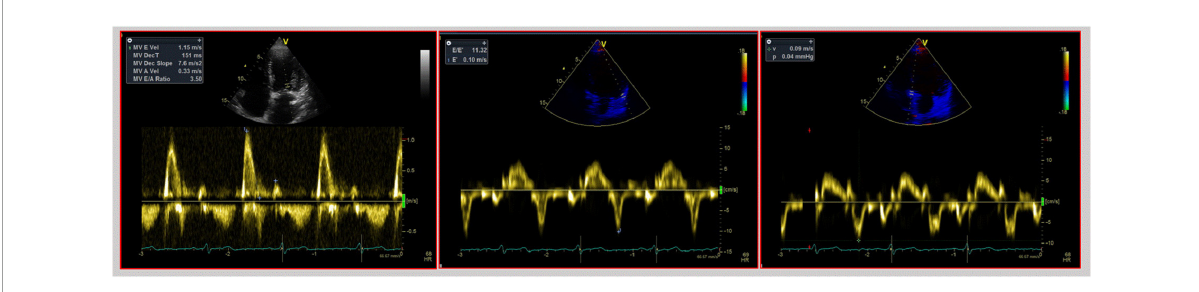
FIGURE2 Echocardiographic assessment of diastolic function in heart transplant. This figure shows a mitral E/A ratio ≥ 2 with a deceleration time of E wave of 151 ms, thus indicating a possible restrictive filling pattern in a 3-year heart transplant patient. However, TDI analysis, shown in the middle and right pictures, shows normal e’ lateral and septal velocities, thus possibly excluding a restrictive filling pattern.